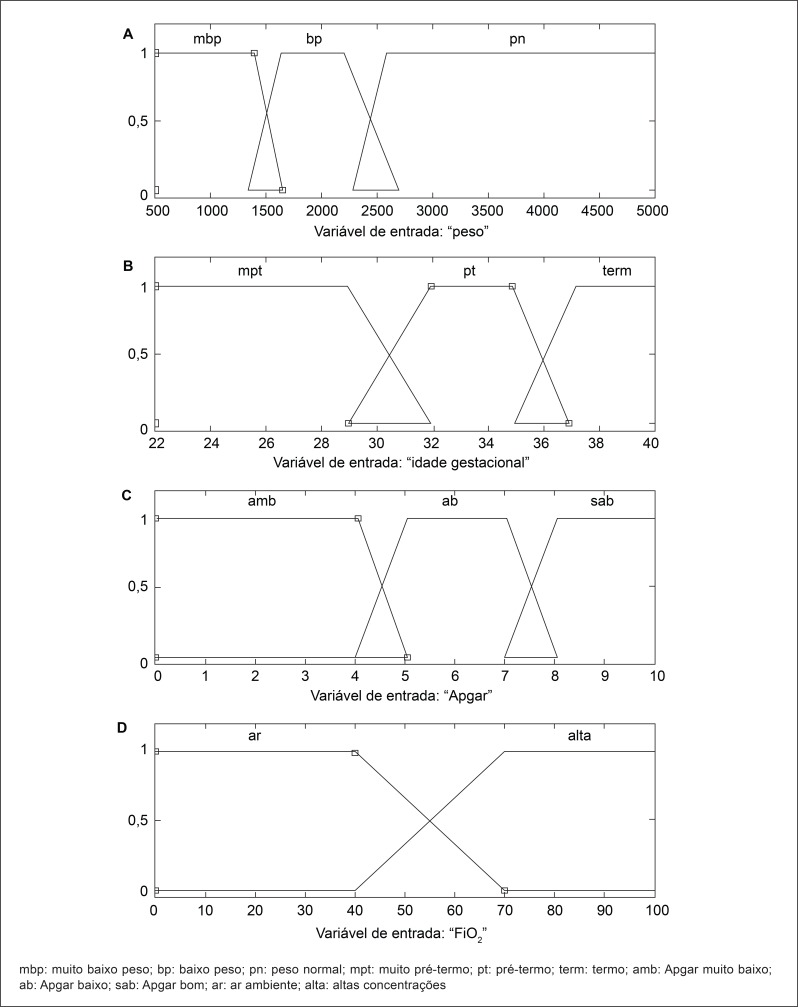
Variáveis de entrada. (A) peso ao nascer em gramas (peso); (B) idade
gestacional em semanas (idg); (C) escore de Apgar; (D) fração inspirada de
oxigênio em porcentagem (FiO2). Taubaté, 2005-2006